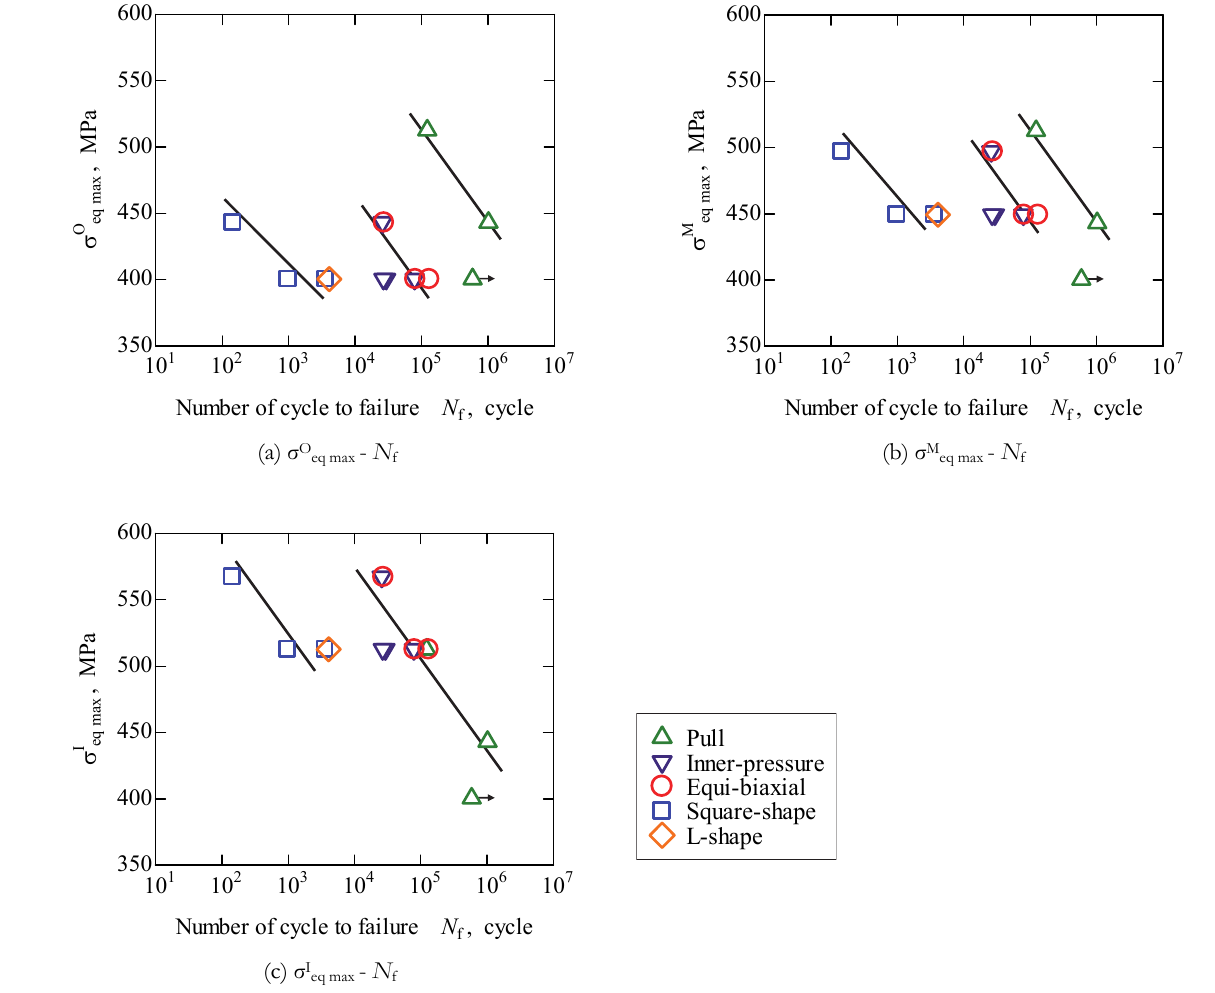
Figure 6: Relationship between maximum Mises stress and N f at each measured